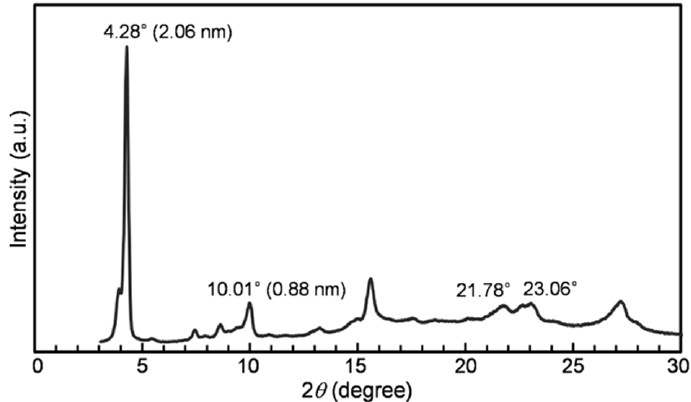
Figure 6. XRD pattern of microsticks.